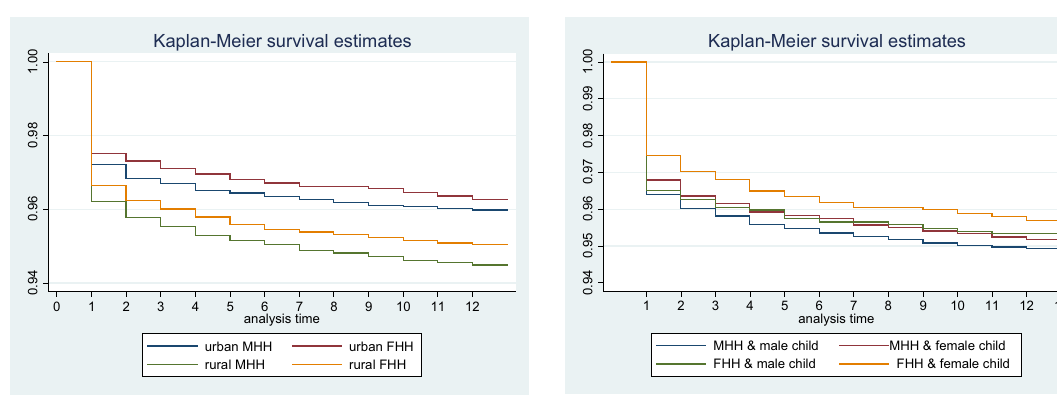
Figure 1 Survival pattern during infancy by place of residence in MHH and FHH, NFHS-3 (2005-06), India